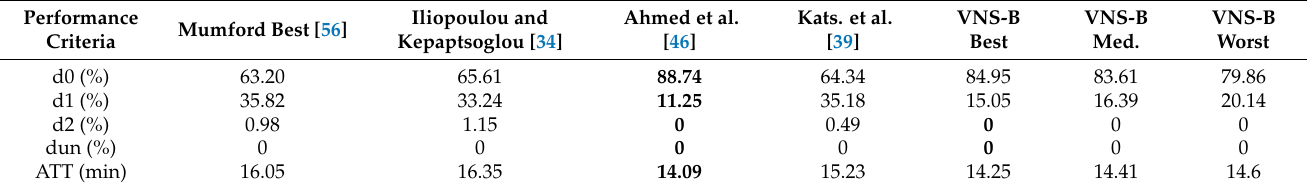
Table 9. Comparison of final solution generated for